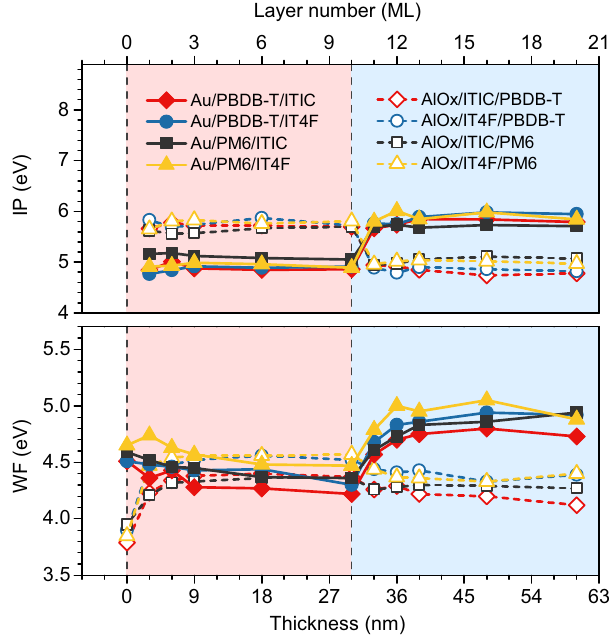
Fig. 2 Mapping the energy level alignment at the donor (D) – acceptor (A) interfaces in monolayer precision. IP (ionization potential) and WF (work function) evolution of Au/D/A (solid lines) and AlO x /A/D (dashed lines) heterojunctions as a function of D, A layer number (top axis) or the corresponding fi lm thickness (bottom axis, presented by taking 3 nm as the average thickness of a monolayer). Upon the donor and acceptor stacking order, the substrate is in white, bottom phase is in red, and top phase is in